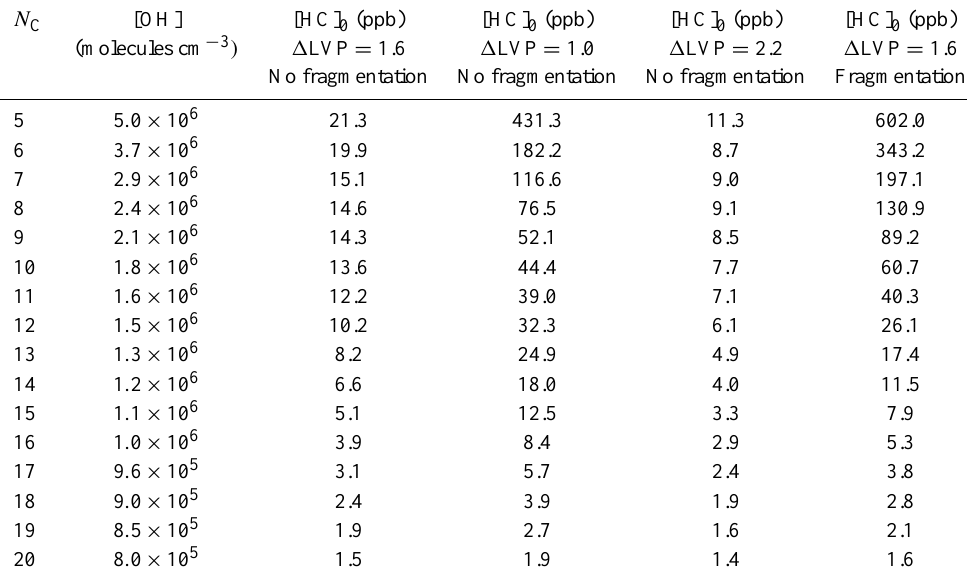
Table 1. Initial hydrocarbon concentrations for the calculations shown in Fig. 2. N